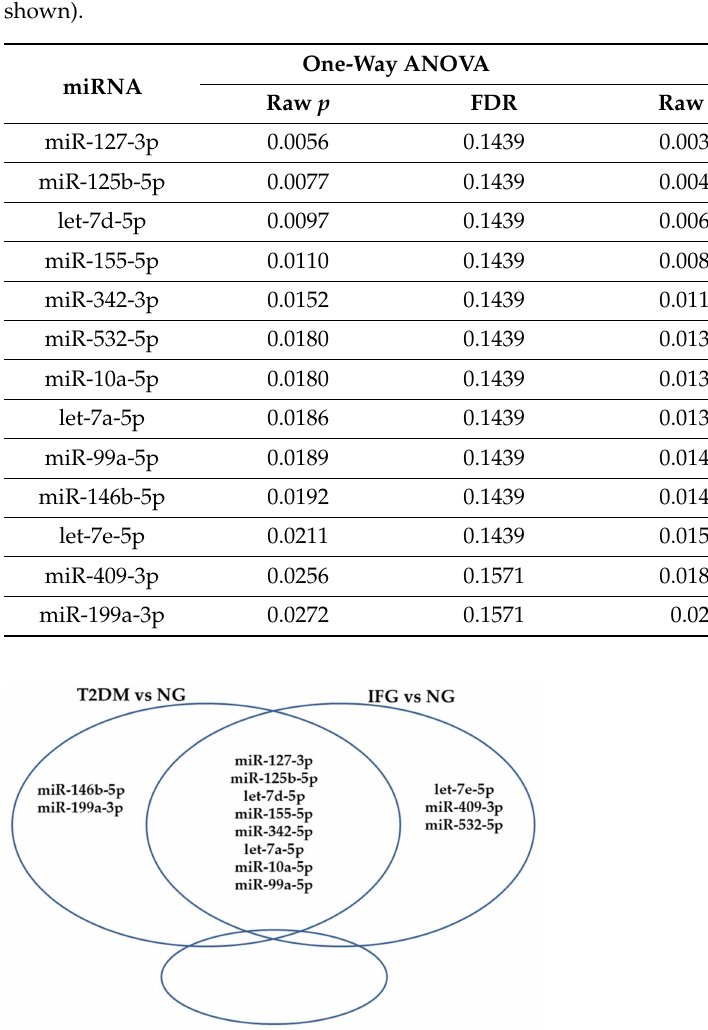
Table 2. Significantly changed miRNAs indicated for intergroup comparisons (T2DM, IFG, NG) by one—way ANOVA (FDR < 0.2) and SAM (FDR < 0.1) for all study subjects (N = 38) along with Spearman’s correlation coefficients for FPG and HbA1c ( p values after FDR correction were only shown).